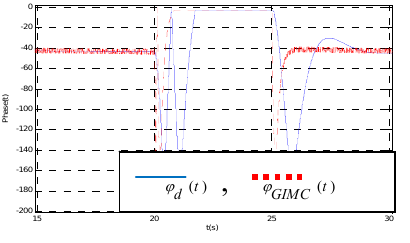
Fig.13. Phase variation: Fig.17. Phase variation: and